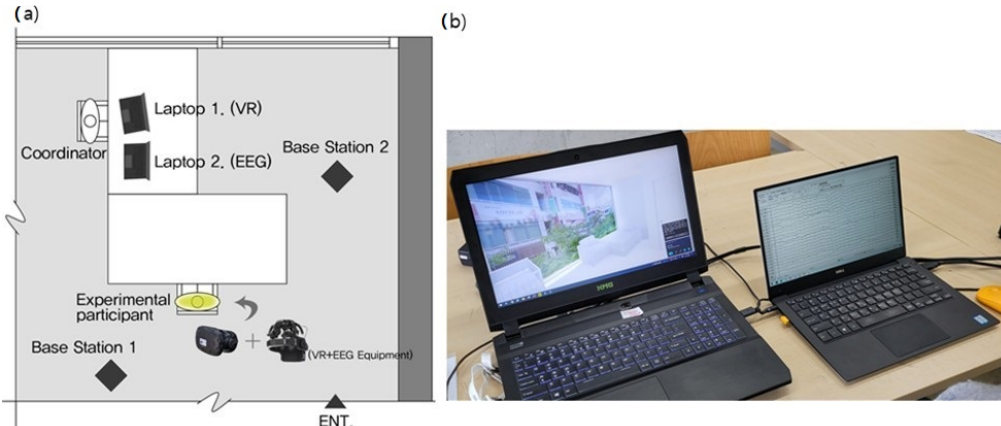
Figure 4. ( a ) Laboratory schematic diagram. The controller operated two laptops in front